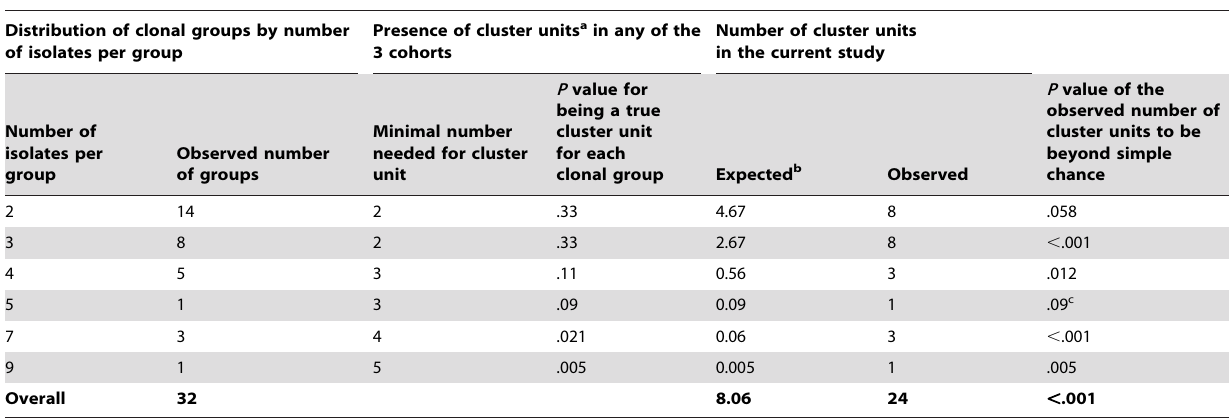
Table 2. Observed and expected cluster units of pneumococcal clones in three cohorts of trainees, Israel, 2007.